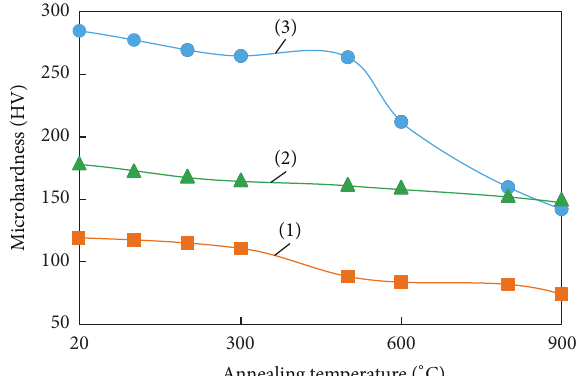
Figure 9: Microhardness of the intermediate layer and its adjacent regions after explosive welding of copper and tantalum plates and subsequent heating of the weld at different temperatures. (1) without heat treatment, (2) heating to 200 ∘ C, (3)300 ∘ C, (4) 500 ∘ C, (5) 600 ∘ C, (6) 800 ∘ C, and (7) 900 ∘